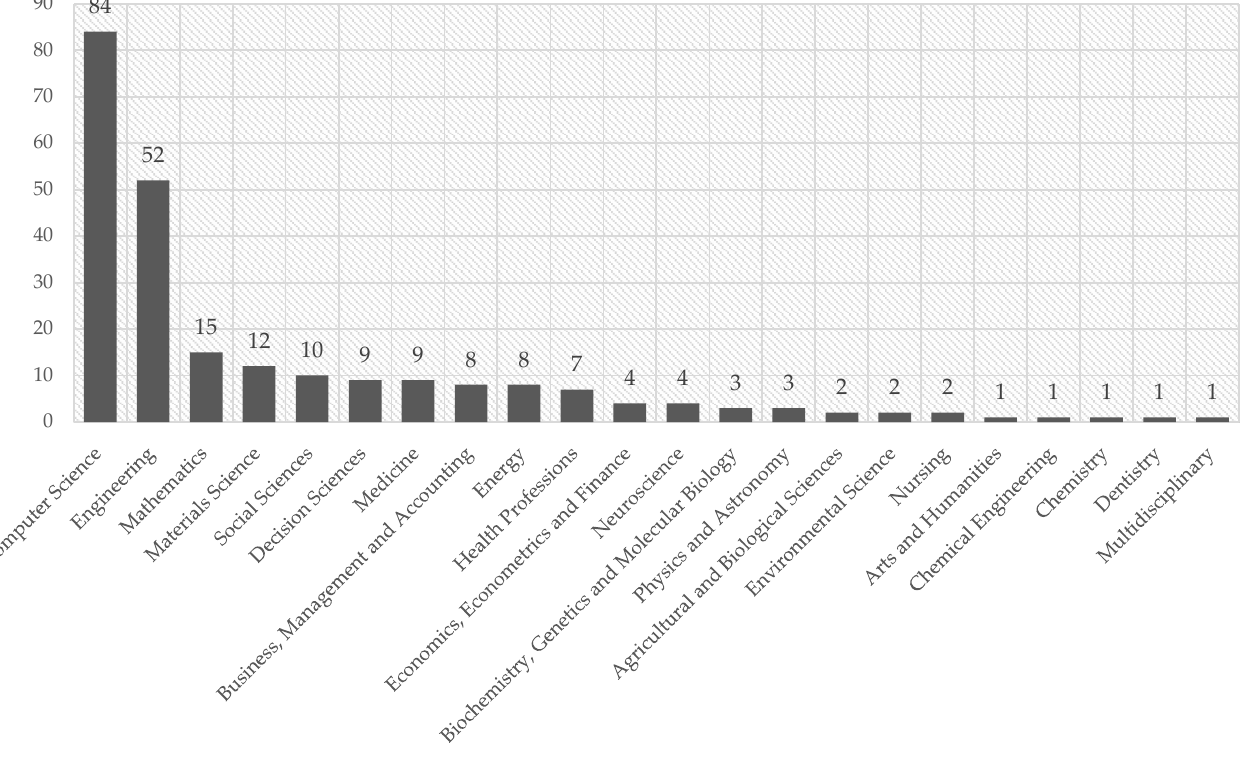
Figure 3. The number of articles published on the topic between 2012 and 2022.